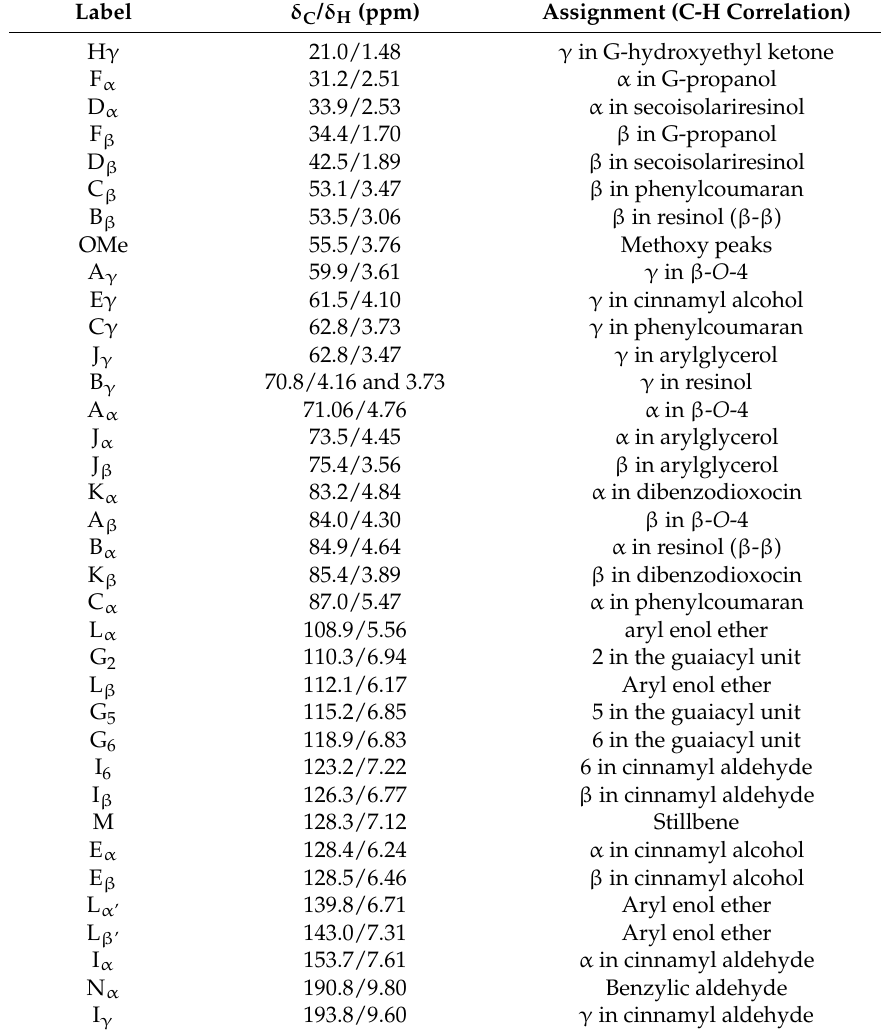
Table 1. Assignment of the identified 13 C- 1 H